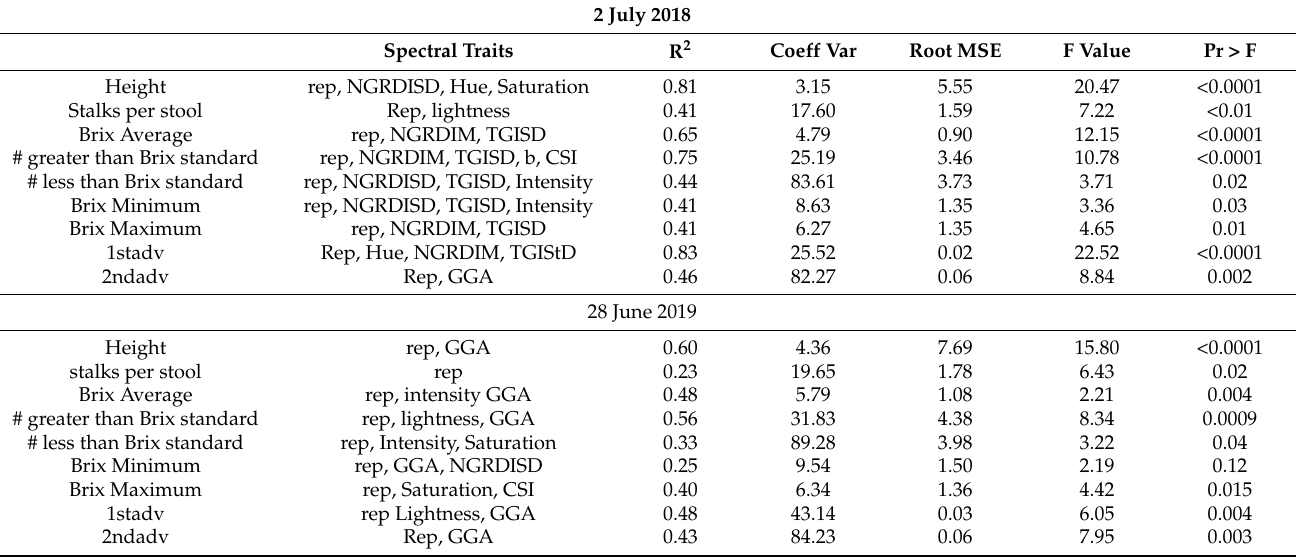
Table 6. Best multiple regression models for the prediction of yield traits by RGB spectral indices.